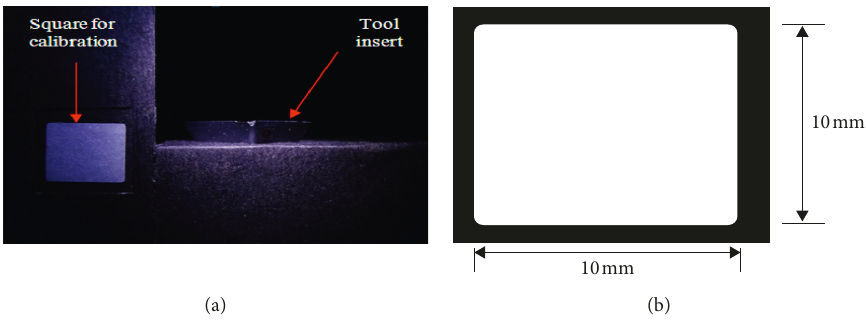
Figure 3: (a) Captured image of the worn out insert; (b) processed image of the calibration